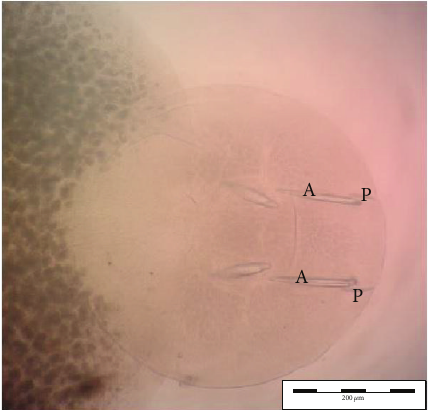
Figure 6: Ventral view of Neobenedenia melleni in compound microscope; A: anterior hamulus 150 𝜇 m; P: posterior hamulus 40 𝜇 m.